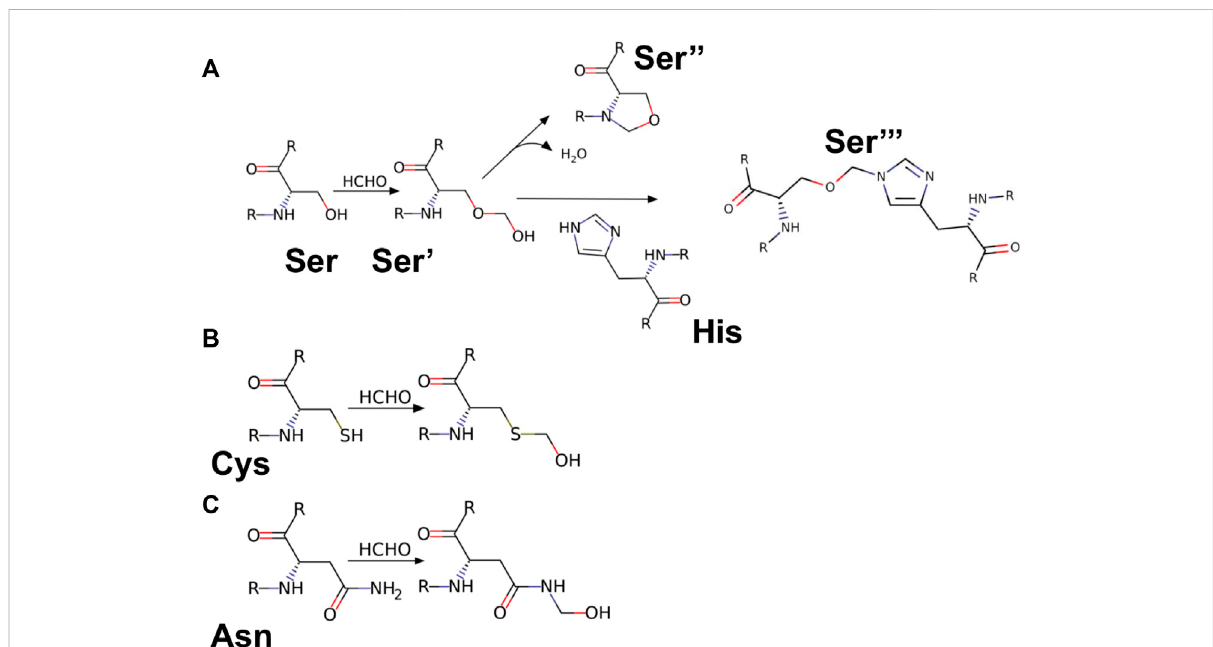
FIGURE 7 Reaction products of HCHO with different amino acids. (A) Amino acid Serine (Ser) reacting with HCHO form methylol derivative [Ser ’ ]; which undergo cyclisation to form oxazolidine adduct [Ser ’‘ ]; the methylol derivative can react with nearby amino acid [case in point amino acid Histidine (His)] to form a crosslink derivative [Ser ’’‘ ]. (B,C) Reaction of HCHO with amino acids Cysteine (Cys) and Asparagine (Asn) forming their respective methylol